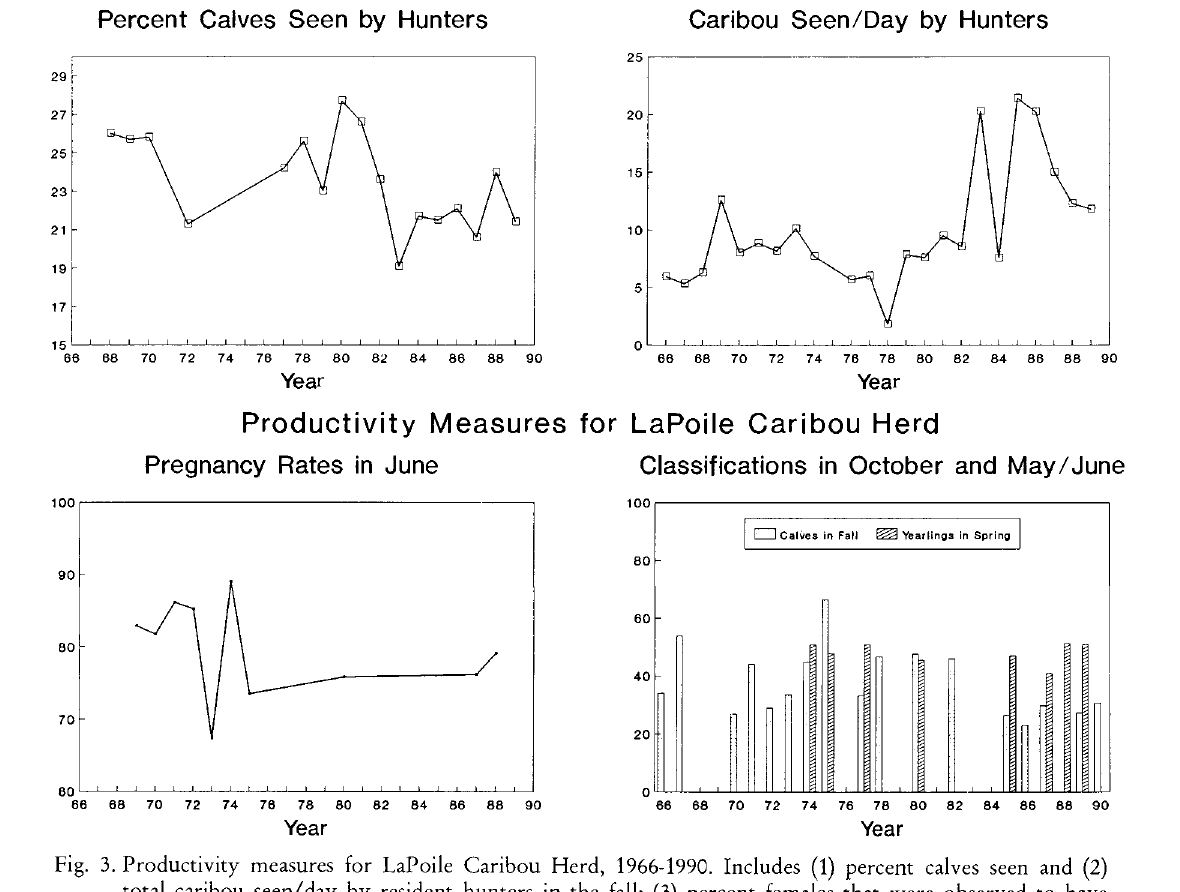
Fig. 3. Productivity measures for LaPoile Caribou Herd, 1966-1990. Includes (1) percent calves seen and (2) total caribou seen/day by resident hunters in the fall; (3) percent females that were observed to have calved in June classification survey; and (4) calves and yearlings/100 females observed on fall and spring classification surveys respectively.